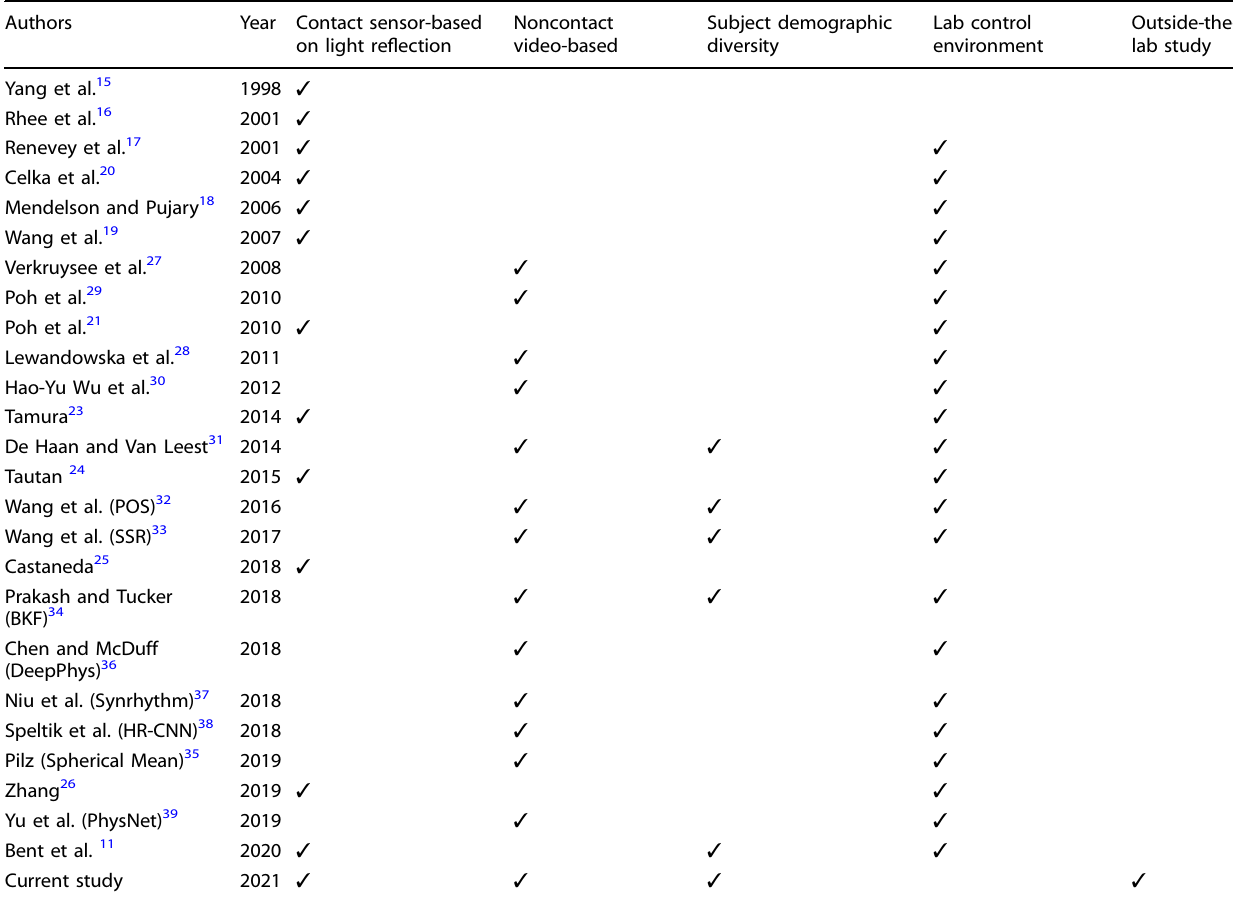
Table 1. Summary of contact-based PPG and rPPG methods for pulse rate